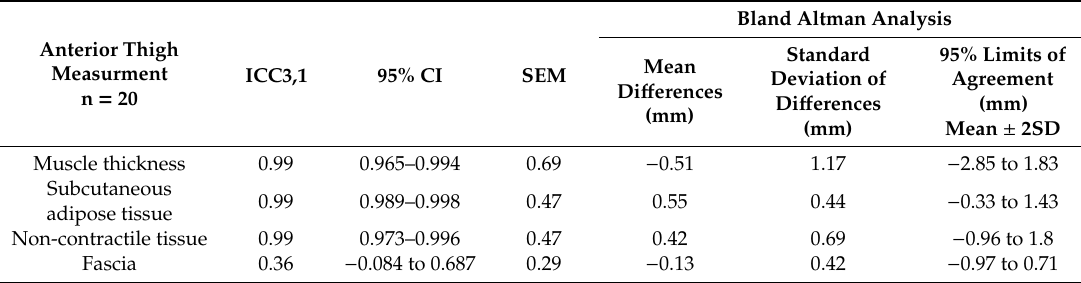
Table 3. Comparison of measurements between MRI and US scans by intra-class correlation coe ffi cients (ICC) and Bland and Altman